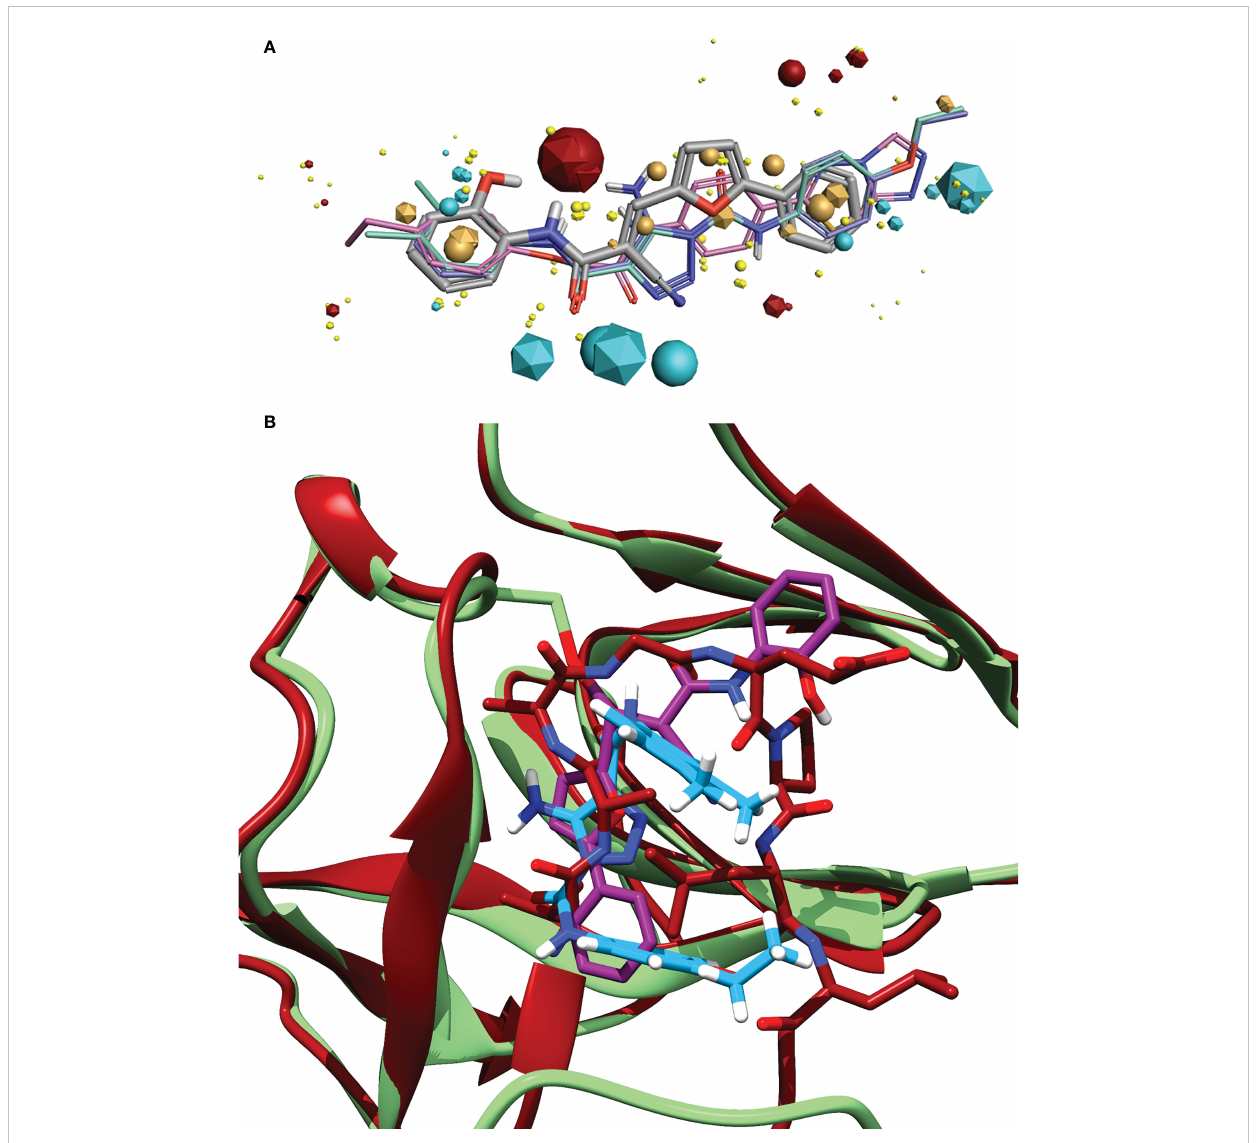
FIGURE 6 (A) Alignment of the identi fi ed compound to three previously identi fi ed inhibitors, showing the similarity of features between the ligands. The key features are represented by the spheres (Compound 1) and icosahedrons (previous inhibitors). Compound 1 is denoted by the grey carbons, and thick bonds. The previous inhibitors GSK-D1 (pink), GSK-C1 (lilac) and the lead from Selwood et al. (Selwood et al., 2018) are represented by thin lines. Red features are electropositive regions, cyan are electronegative, tan are hydrophobicity fi elds and yellow van der Waals fi elds. The size of the fi eld corresponds to the size of the effect. Image generated using Flare ™ from Cresset ® . (B) An alignment of the C-form of LexA (red) with GSK-C1 (blue) and compound 1 (purple) bound to the NC-form of LexA (green). This shows the similarity of these compound conformations to the b -turn of the